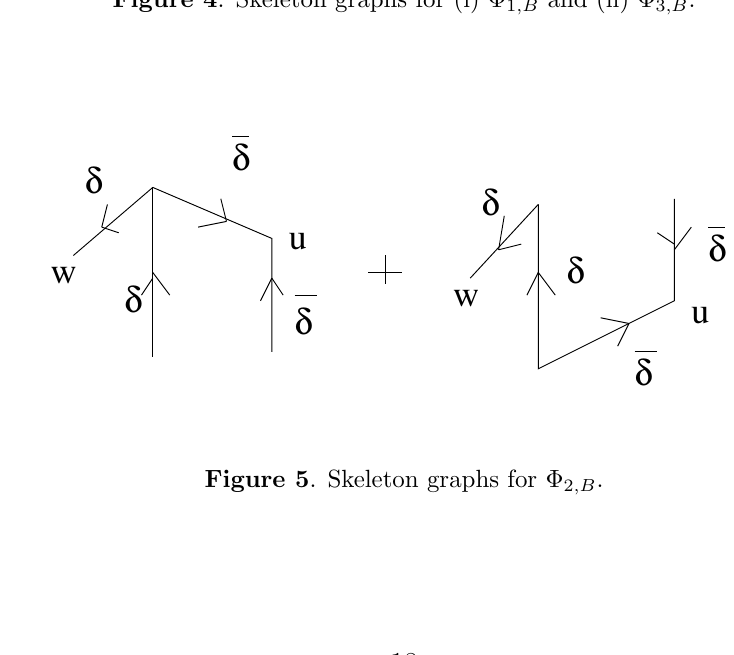
Figure 4 . Skeleton graphs for (i) (cid:8) 1 ;B and (ii) (cid:8) 3 ;B .